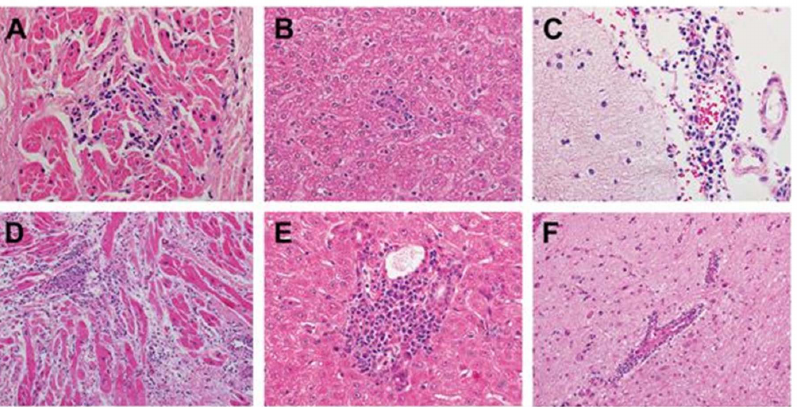
Figure 2. Postmortem histopathologic findings (hematoxylin-eosin (H&E) stain) of two cynomolgus monkeys injected with 10 7 pfu of CVB3-H3. Myocardium from both FP42 (A (200X)) and FP49 (D (200X)) showed evidence of viral myocarditis, consisting of focal predominantly lymphocytic mononuclear inflammatory infiltrates with myocyte injury. In addition, representative sections of the liver from both animals exhibited changes of mild viral hepatitis including focal mononuclear inflammatory infiltrates within the hepatic lobules (B (FP42)) and portal tracts with associated interface hepatitis (E (FP49)). The central nervous system exhibited perivascular lymphocytic infiltrates within the leptomeninges (C (FP42)) and intracerebral blood vessels (F (FP49)) with microglial proliferation and nodules (not shown). These changes are indicative of viral meningitis and encephalitis (meningoencephalitis).